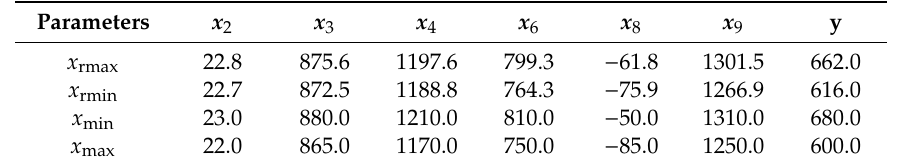
Table 4. Extreme values of parameters.